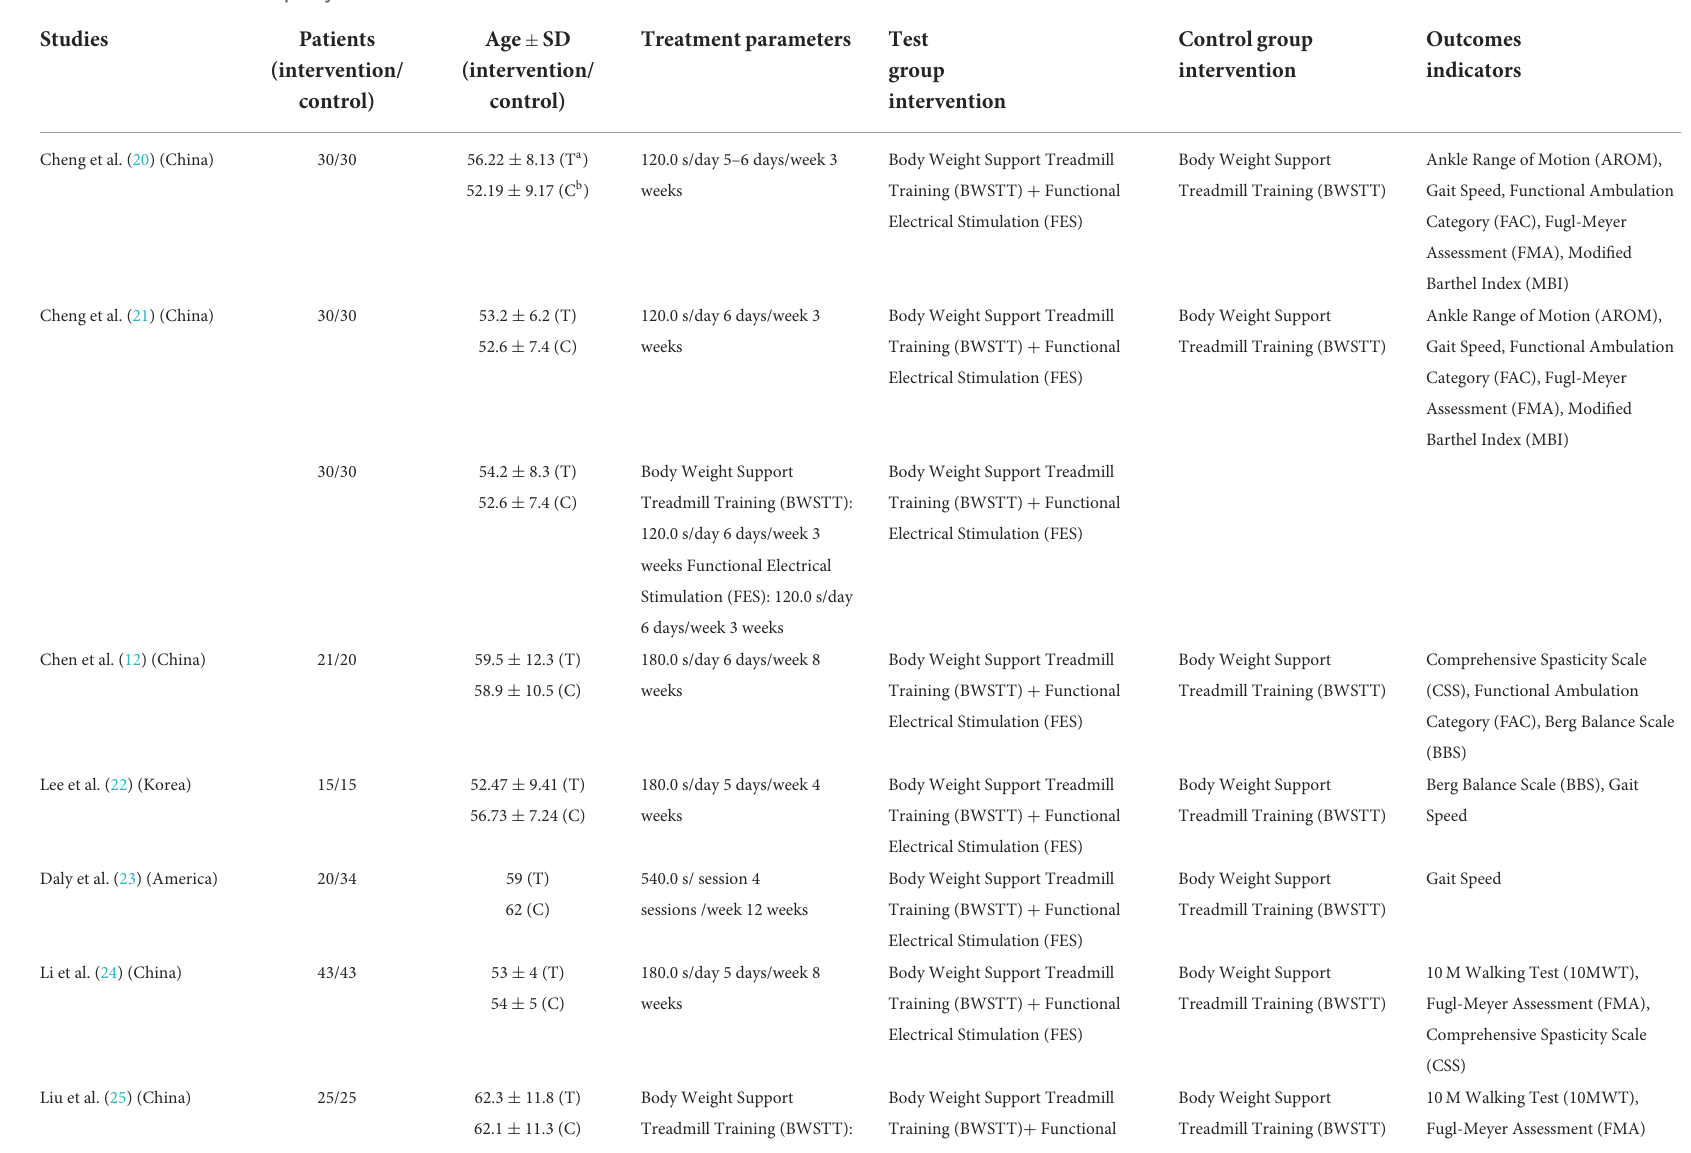
TABLE 1 Characteristics and quality assessments of the included